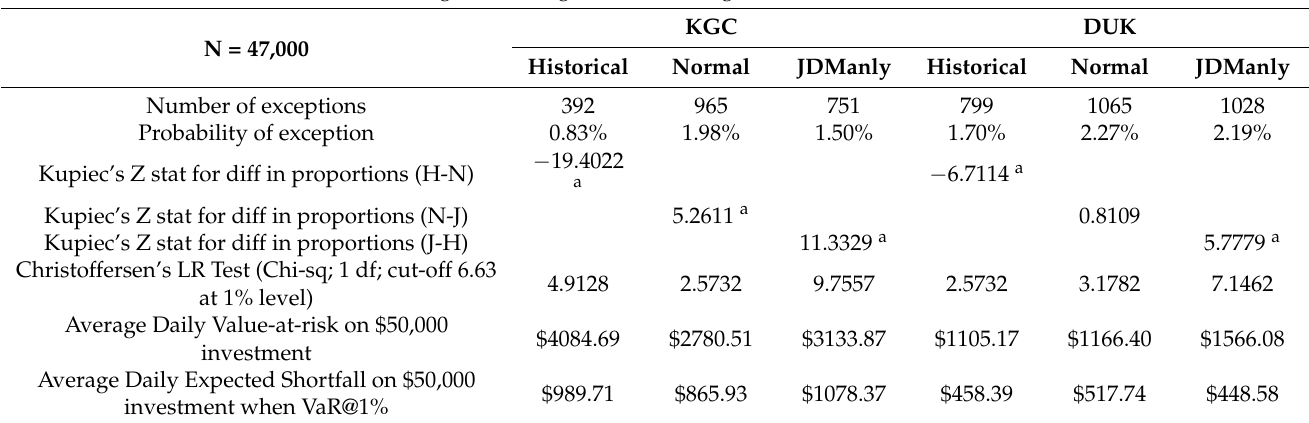
Table 3. Results of backtesting value-at-risk and expected shortfall estimates from the three models. Panel A. Results for the KGC and DUK stocks from the US market, based on 100 day rolling estimation window, and 125